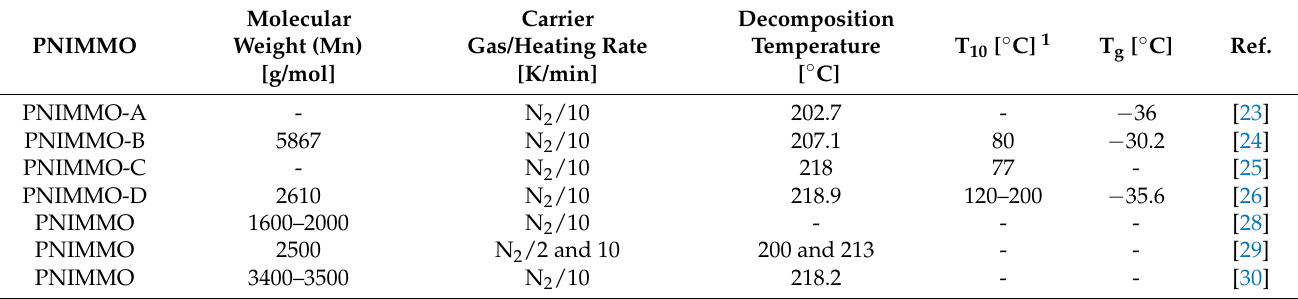
Table 1. Summary of DSC and supporting data for PNIMMO reported in